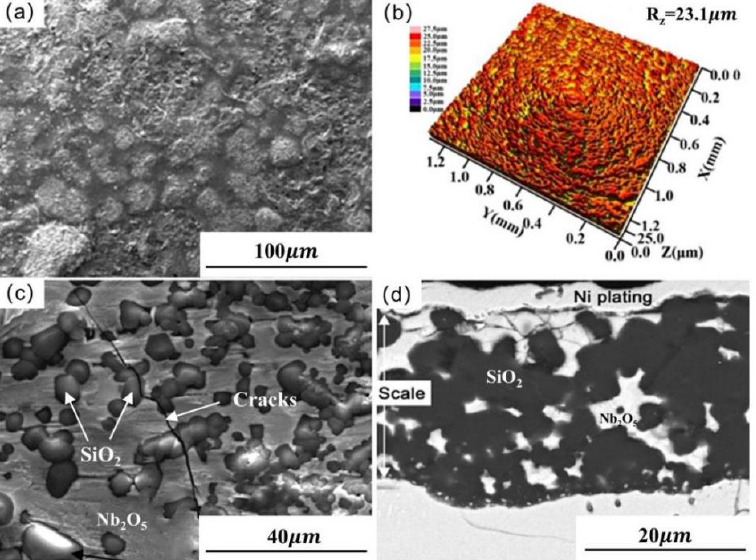
Figure 6. SEM and LSCM images of SPS coatings after oxidation at 1500 °C for 43 h. ( a ) Secondary electron image; ( b ) LSCM image; ( c ) Backscattered electron image; ( d ) Cross-sectional images.